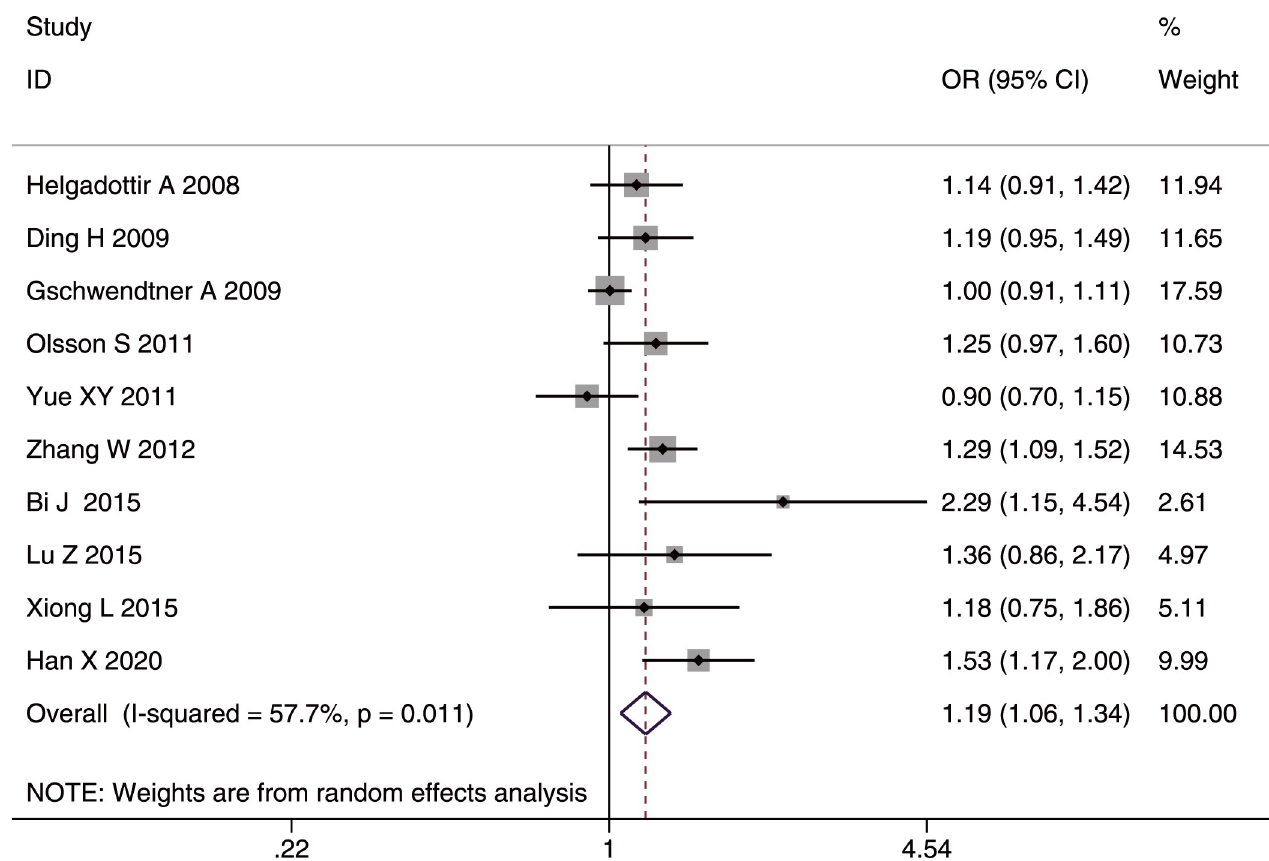
Fig 4. Forest plot of rs10757278 genotype frequency (GG vs. (AA+GA)) in the whole studied population.